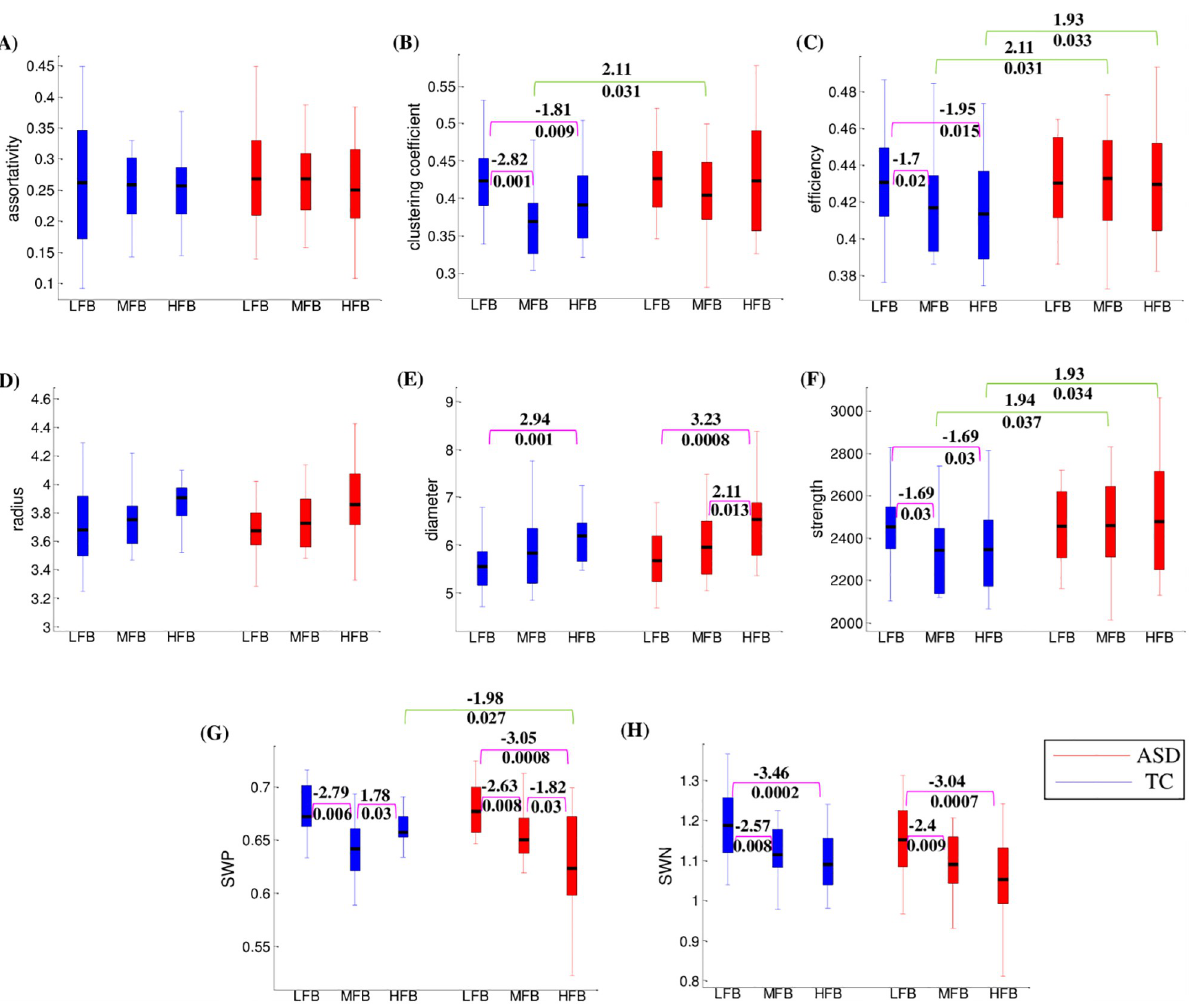
Fig 3. Comparing the graph global metrics between groups and between graph frequency bands. The results are for (A) Assortativity, (B) Clustering coefficient, (C) Efficiency, (D) Radius, (E) Diameter, (F) Strength, (G) SWP, and (H) SWN metrics. The green and pink color lines show the results between groups and frequency bands, respectively. The values above and under the lines are statistical t and corresponding corrected p values, respectively. The values mentioned above are only provided for significant results ( p < 0 . 05